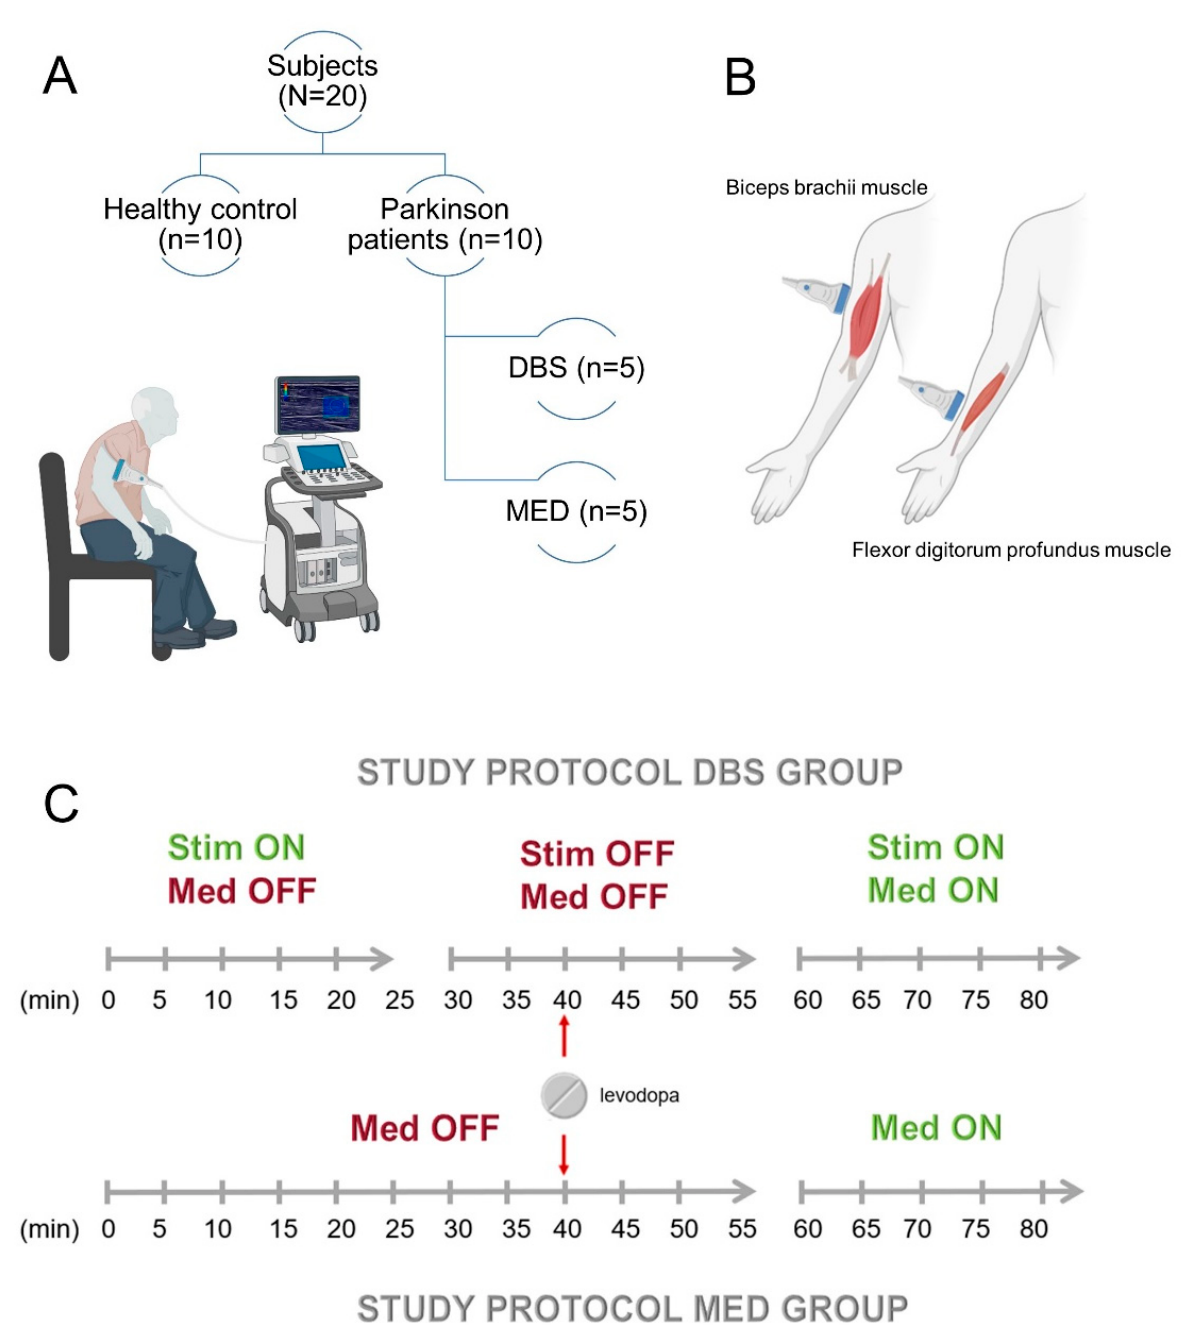
Figure 2. ( A ) The figure depicts the measurement setup; the patients were comfortably seated on a chair while the upper extremity was examined sonographically. The subject collective consisted of a total of 10 healthy controls and 10 Parkinson’s disease patients; of the latter, 5 were treated with deep brain stimulation (DBS), and 5 with medication (MED). ( B ) The biceps brachii muscle and flexor digitorum muscle were measured. ( C ) Illustration of the experimental protocol of the longitudinal measurement over 80 min. Shear wave velocity and the Unified Parkinson’s Disease Score were assessed every five minutes. Rigidity was modulated: at minute 40, the regular medication containing levodopa with benserazide or carbidopa was administered as a tablet (MED ON) to both parallel groups. In the DBS group, stimulation was additionally switched off between minutes 30 and 55 (STIM